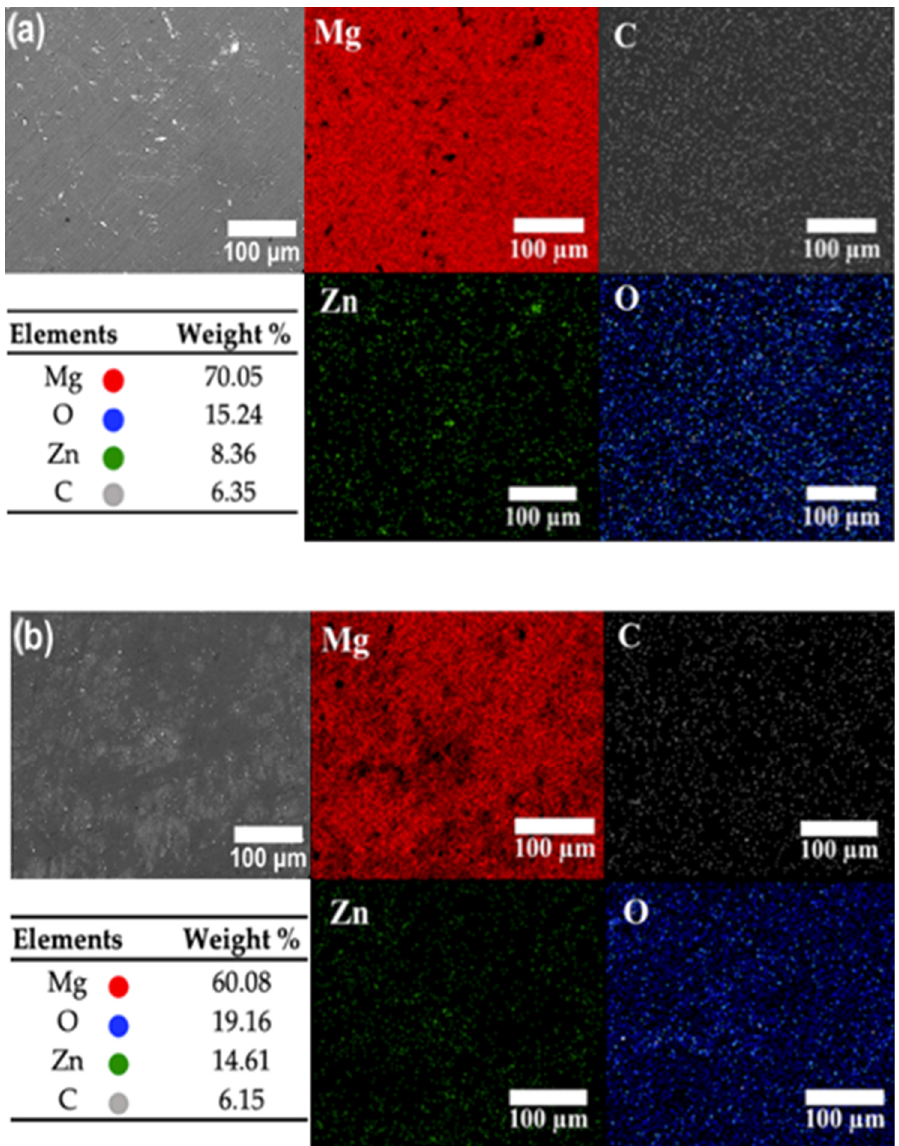
Figure 4. EDS mapping (200×) of the elements present in the electroless deposits on Mg–Ca0.3, obtained from 10 − 3 M solutions of ZnO ( a ) and Zn(NO 3 ) 2 ( b ).